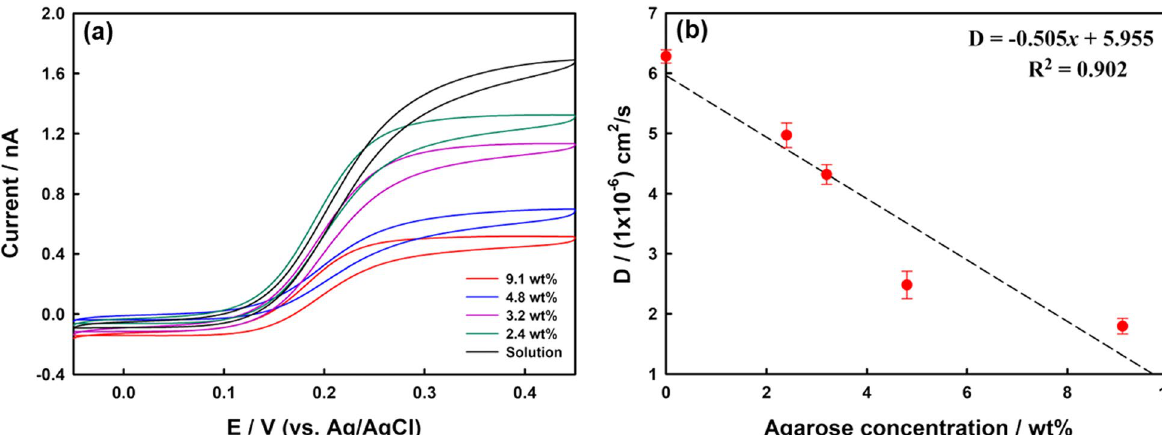
Fig. 3 a CV curves of the Au UME (25 μm diameter) in the agarose hydrogel depending on the agarose concentration (colored line) and in solution (black line) containing 0.5 mM Fe(CN) 64– and 0.1 M KCl. Scan rate: 10 mV/s. b D of Fe(CN) 64– as a function of the agarose concentration. Error bars are obtained based on three independent measurements